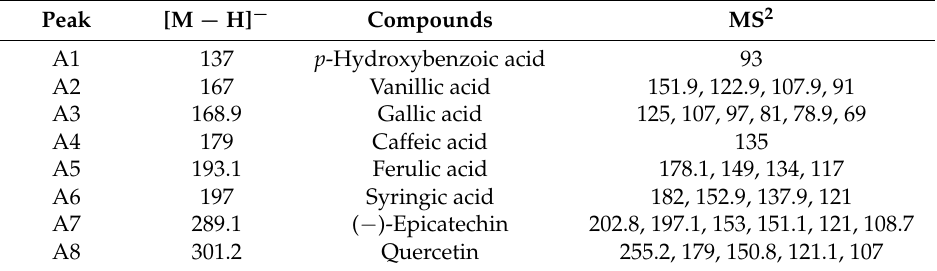
Table 2. Identification of phenolic compounds from distiller’s grain extract by UPLC-MS/MS. Peak [M − H] − Compounds MS 2 A1 137 p -Hydroxybenzoic acid 93 A2 167 Vanillic acid